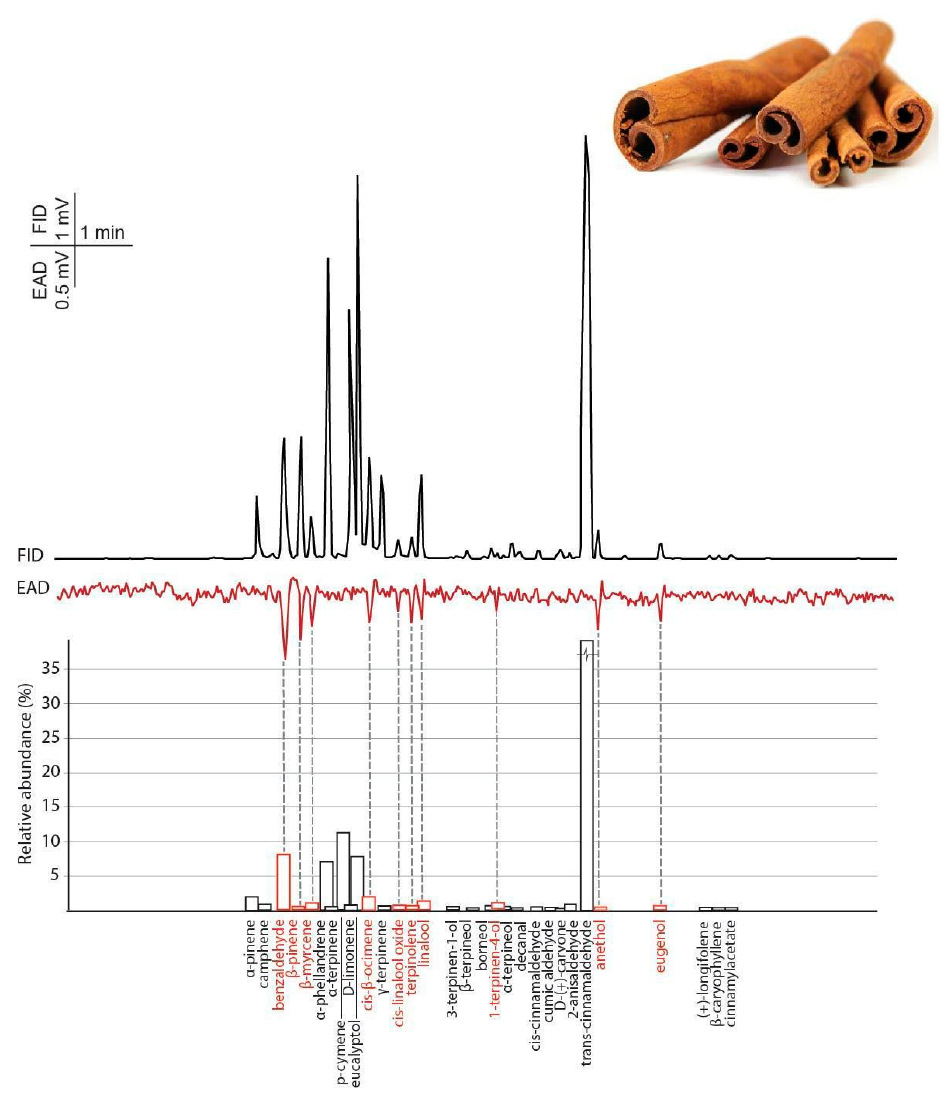
Figure 3. The averaged antennal response (EAD) of female box tree moths ( Cydalima perspectalis ) to cinnamon essential oil headspace samples (collected with SPME) measured by gas chromatography coupled electroantennographic detection (GC-EAD) (n = 5). Bars indicate the relative abundance of volatile constituents based on GC-MS analysis. The names of antennal active volatiles are highlighted in red.